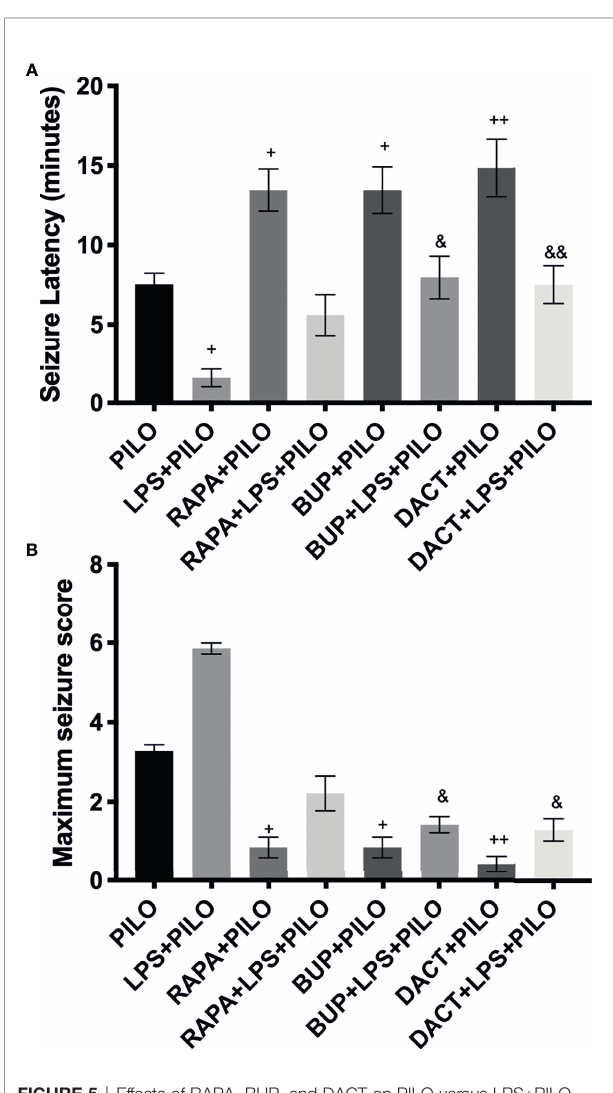
FIGURE 5 | Effects of RAPA, BUP, and DACT on PILO versus LPS+PILO- induced seizures in male C57BL/6 mice. (A) Latency to seizures. The data are represented as mean ± SEM (n = 6) and analyzed by one-way ANOVA followed by Tukey – Kramer multiple comparison tests. (B) Seizure score. The data are represented as mean ± SEM (n = 6) and analyzed by Kruskal – Wallis analysis by ranks followed by Dunn ’ s multiple comparison tests. The signi fi cance is ascertained as ++ p<0.01 versus PILO, + p < 0.05 versus PILO, && p<0.01 versus LPS+PILO, and & p<0.05 versus